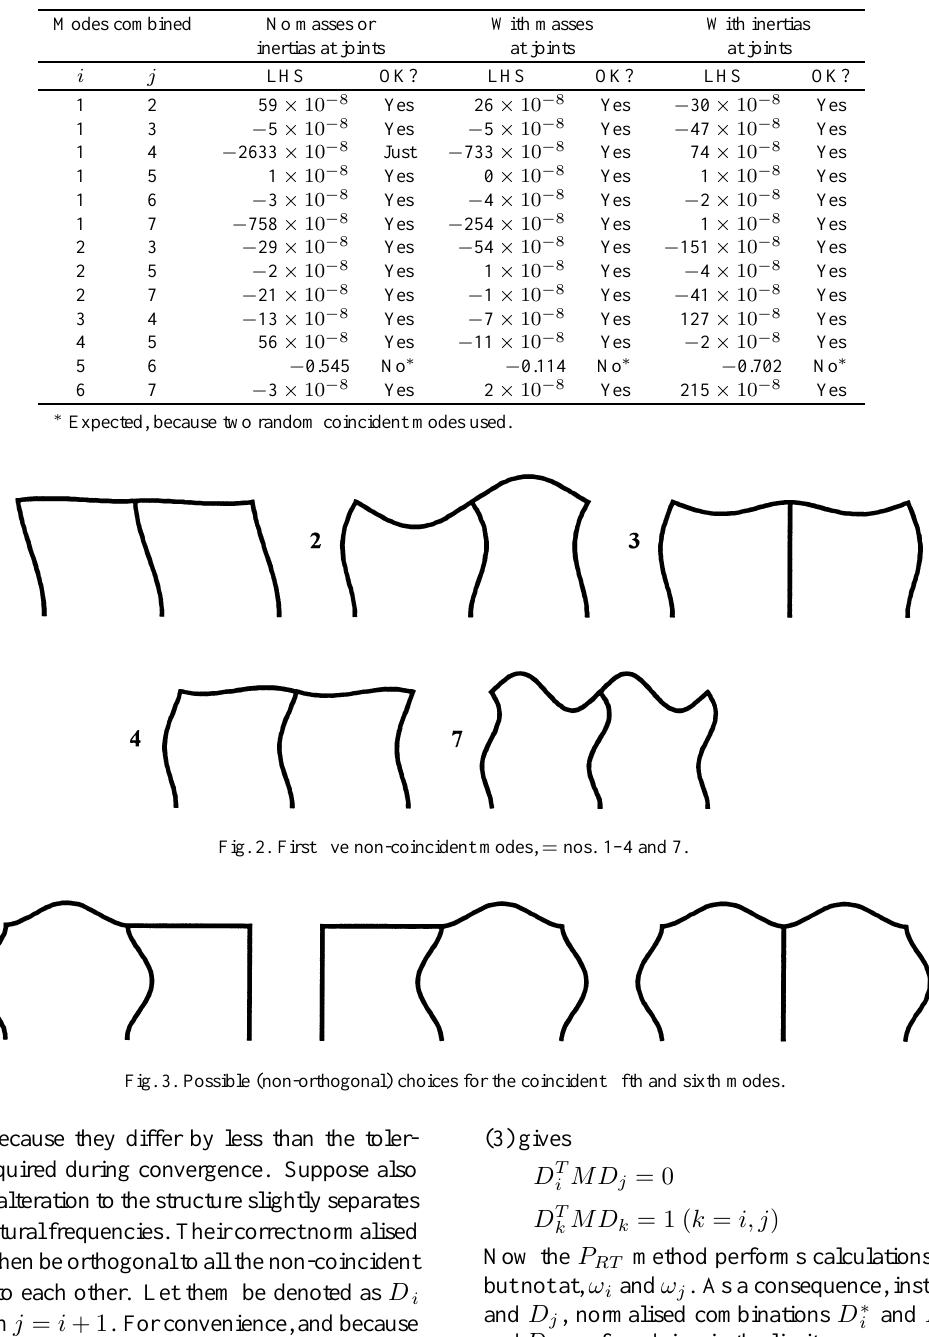
Table 1 Check on the correctness of the orthonormalisation conditions of Eq. (2), as judged by approximate satisfaction (denoted by Yes in the table) of Eq. (9) by the LHS of Eq. (2)